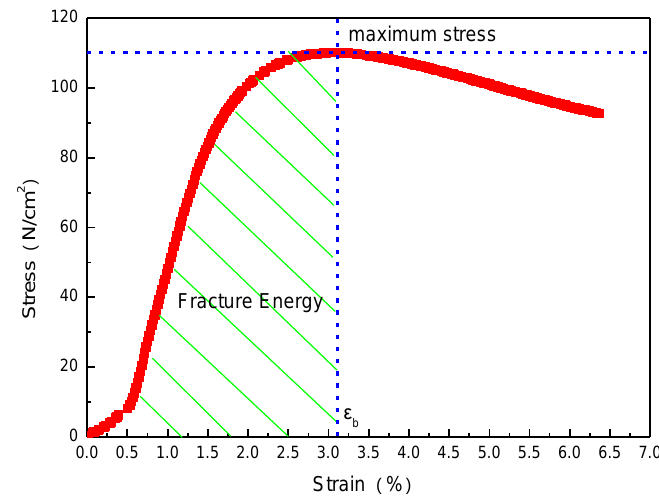
Figure 1. Calculation of fracture energy and failure strain.